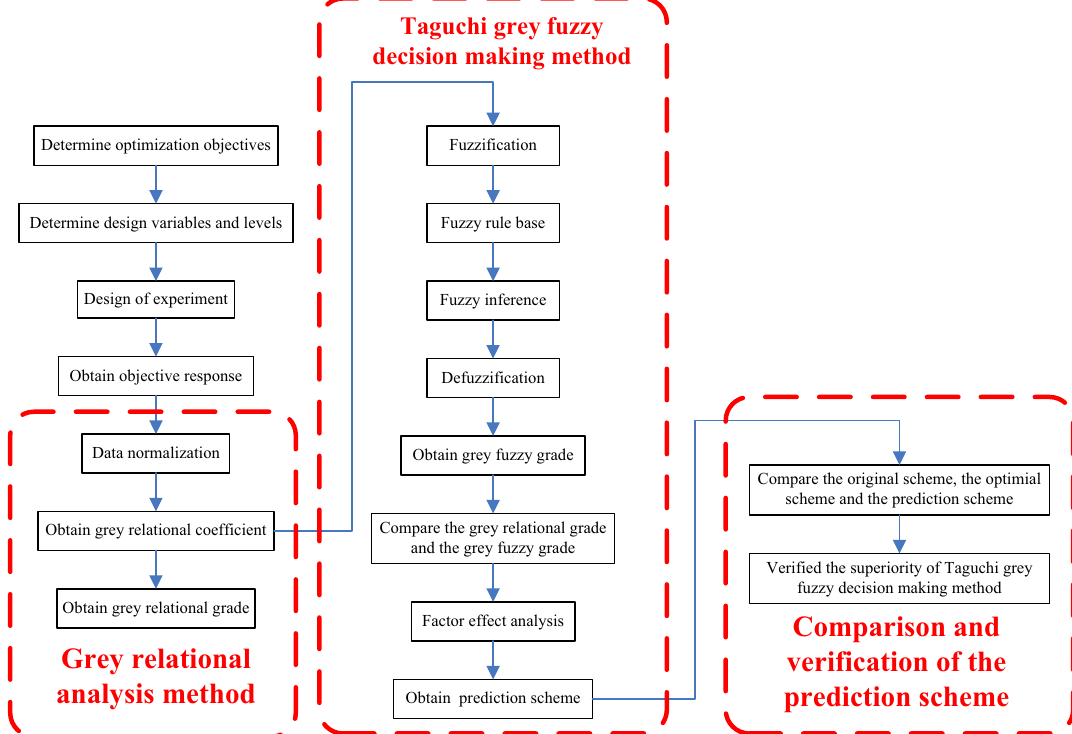
Figure 3. The flow chart of multi-objective optimization method for protein electrophoresis microfluidic chip.